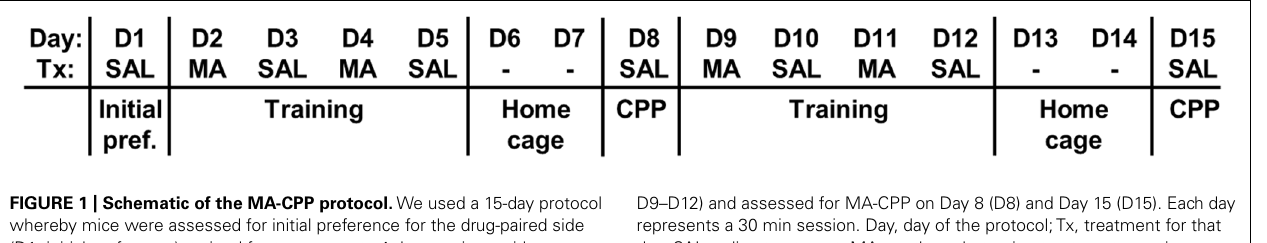
D9–D12) and assessed for MA-CPP on Day 8 (D8) and Day 15 (D15). Each day represents a 30 min session. Day, day of the protocol;Tx, treatment for that day; SAL, saline treatment; MA, methamphetamine treatment; − , mice were left undisturbed in their home cage in the vivarium on these